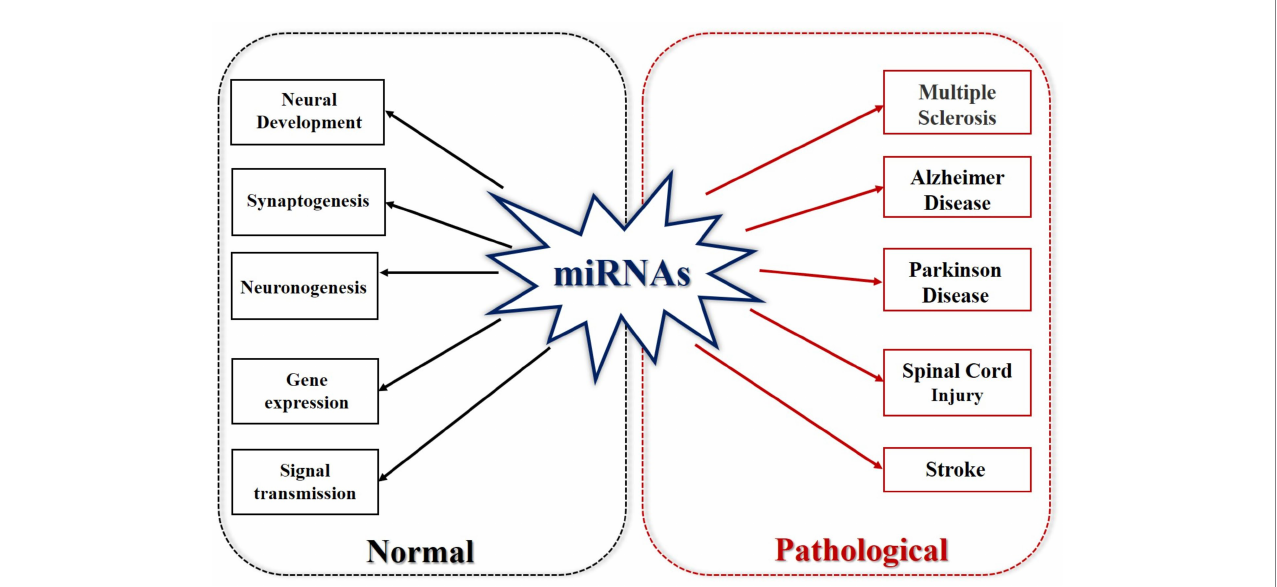
FIGURE 2 MicroRNAs in normal and pathological states. Under normal circumstances, miRNA is involved in neural development, synaptogenesis, neurogenesis, gene expression, and signal transmission. In its pathological state, miRNA is involved in multiple sclerosis, Alzheimer’s disease, Parkinson’s disease, SCI and stroke.